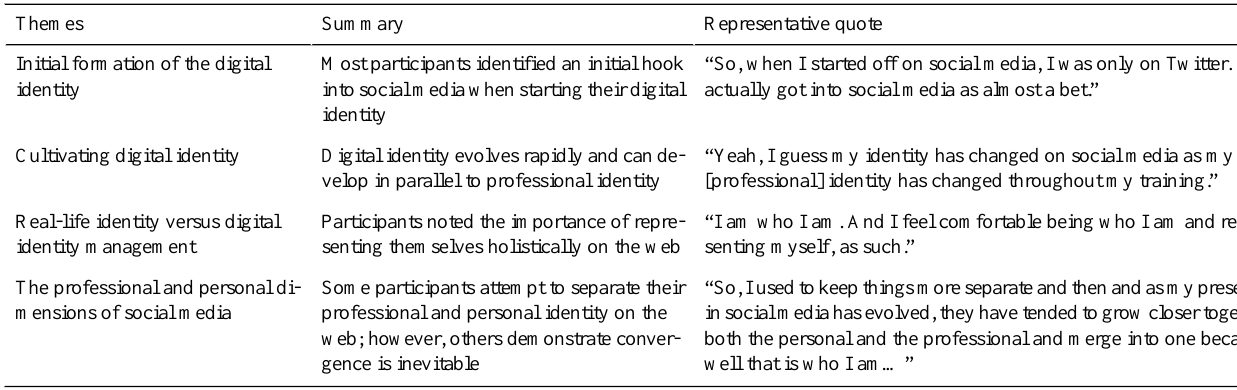
Table 3. Major themes in the construct of digital